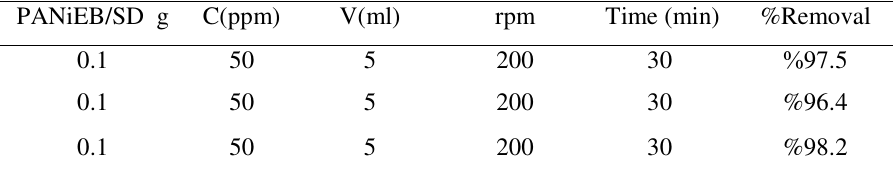
Table 2 Sorption of lead ion by regenerated PANi/SD